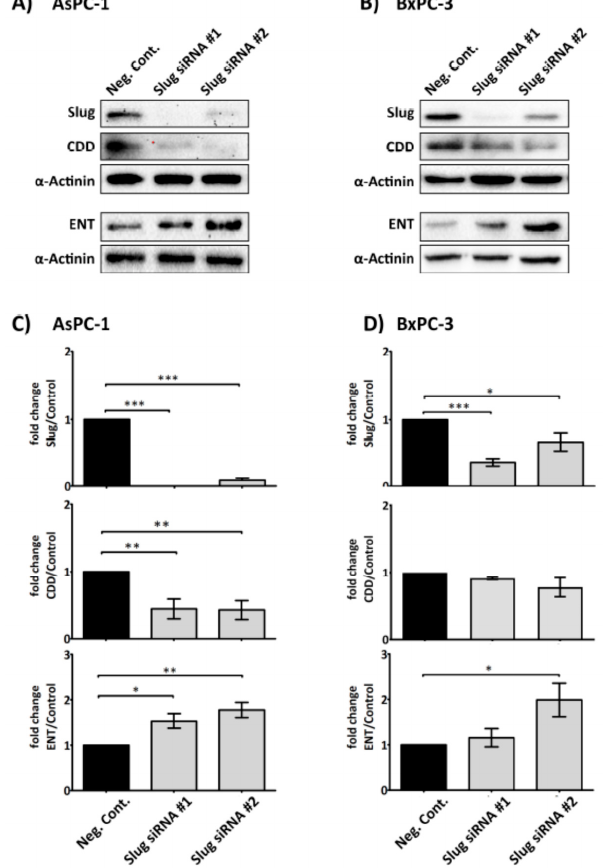
Figure 4. Slug mediates the expression level of CDD and hENT1 in PDAC. Representative immunoblots ( A ) and ( B ) show the expression of Slug, hENT1 and CDD in AsPC-1 and BxPC-3 after Slug-specific siRNA treatment. 3 × 10 5 cancer cells were seeded in 6-well plate for 24 h. Slug siRNAs (the number #1 and #2 designate two different Slug siRNA sequences) or a negative control siRNA (75 nM) in serum/antibiotic-free media were added to the adherent cells and incubated for 24 h. The media was then replaced with fresh media (+10% fetal bovine serum (FBS)) and cells incubated for a further 24 h before cells were lysed and examined for the expression of the proteins of interest. Bar graphs ( C ) and ( D ) show the expression of Slug, hENT1, CDD and loading control α -actinin in AsPC-1 and BxPC-3 post siRNA treatment. The expression levels were quantified relative to the loading control. The columns represent the fold change of protein levels relative to the negative control siRNA treated cells ( n ≥ 3). Data are presented as mean ± SEM. One way ANOVA with post-hoc Bonferroni’s Multiple Comparison Test was used to examine the significance of the mean *** p < 0.0001, ** p < 0.001, * p < 0.05. Neg. Cont.: negative